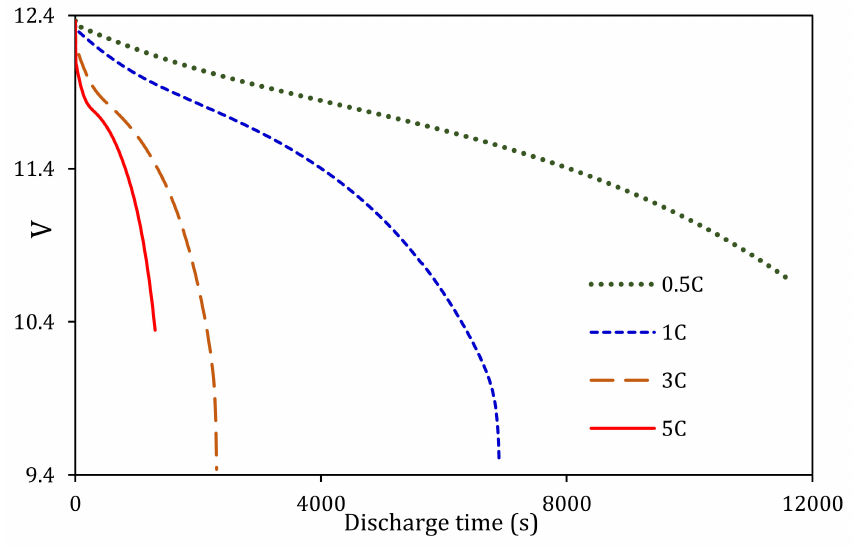
Figure 7. LIB voltage versus discharge time, showing the full module connected for 3S2P at 0.5C, 1C, 3C, and 5C discharge